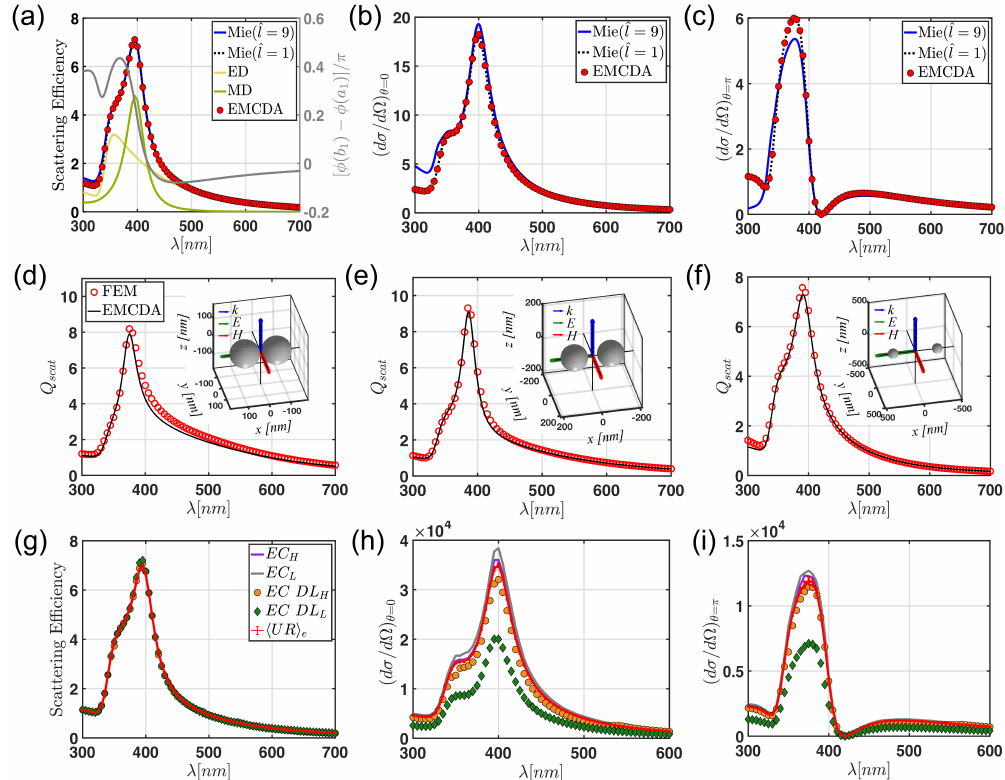
Figure 13. ( a ) Scattering efficiency of a single TiO 2 nanoparticle ( R = 70 nm) evaluated by using the Mie–Lorentz theory by truncating ˆ l up to the convergence order provided by ˆ l = x + 4.05 x 1/3 + 2 [87] ( x is the size parameter) as compared to both the analytical result with only the dipolar contribution (ˆ l = 1) and the numerical electric and magnetic coupled dipole approximation (EMCDA) calculation (red circle markers). The electric dipole (ED) and the magnetic dipole (MD) contributions are also shown. The grey-left y -axis indicates the phase difference ∆ φ = φ ( b 1 ) − φ ( a 1 ) , normalized with respect to π , between the magnetic and electric dipole. Here, a 1 and b 1 are the Mie–Lorentz coefficients evaluated by using Equation (20) with ν = 1. Panels ( b , c ) show the same benchmark for the differential scattering efficiency in the forward and backward direction, respectively. Panel ( d – f ) displays the benchmark between the EMCDA and the finite element method (FEM) technique applied to different dimer nanoparticle ( R = 70 nm) configurations characterized by an interparticle separation of 10 nm, 50 nm, and 450 nm, respectively. Panels ( g – i ) show, respectively, the scattering efficiency and the differential scattering efficiency in the forward and backward directions of EC H (violet line), EC L (grey line), EC DL H (circle orange markers), EC DL L (green diamond markers), and UR (red line) arrays rescaled to avoid touching scatterers. The error bars of the UR case are evaluated as the standard deviation over 20 different disorder